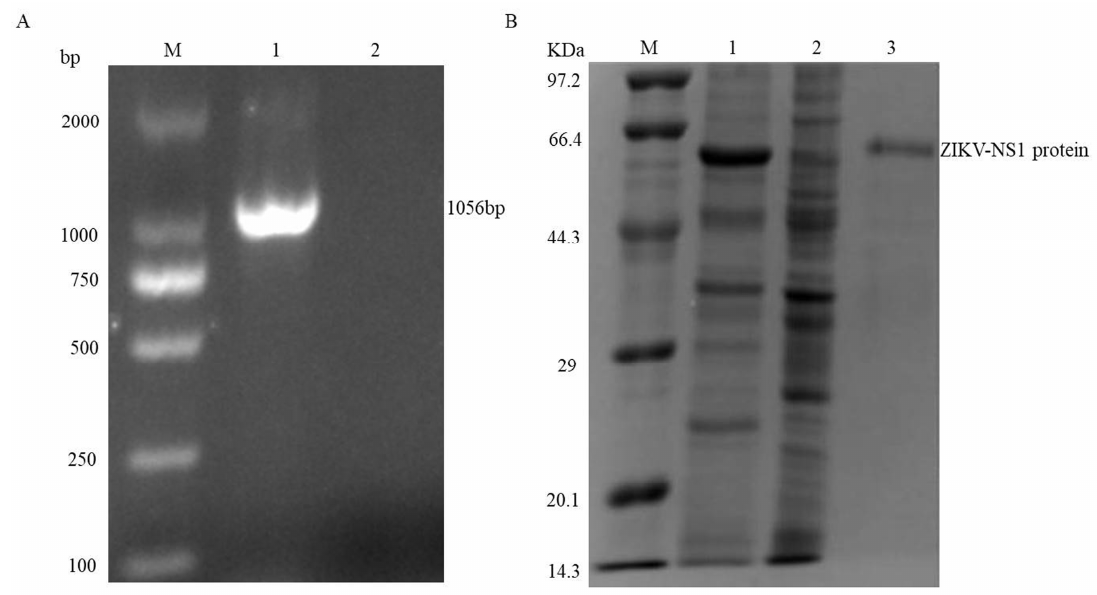
Figure 1. Analysis of the recombinant vector construction and expression of recombinant ZIKV-NS1 protein. ( A ) Identification of the positive clone of pET-32a-NS1 by bacteria polymerase chain reaction, lane 1: positive clone; lane 2: blank control. ( B ) Lane 1: E. coli was induced with IPTG; lane 2: E. coli before induced; lane 3: the purified ZIKV-NS1 after